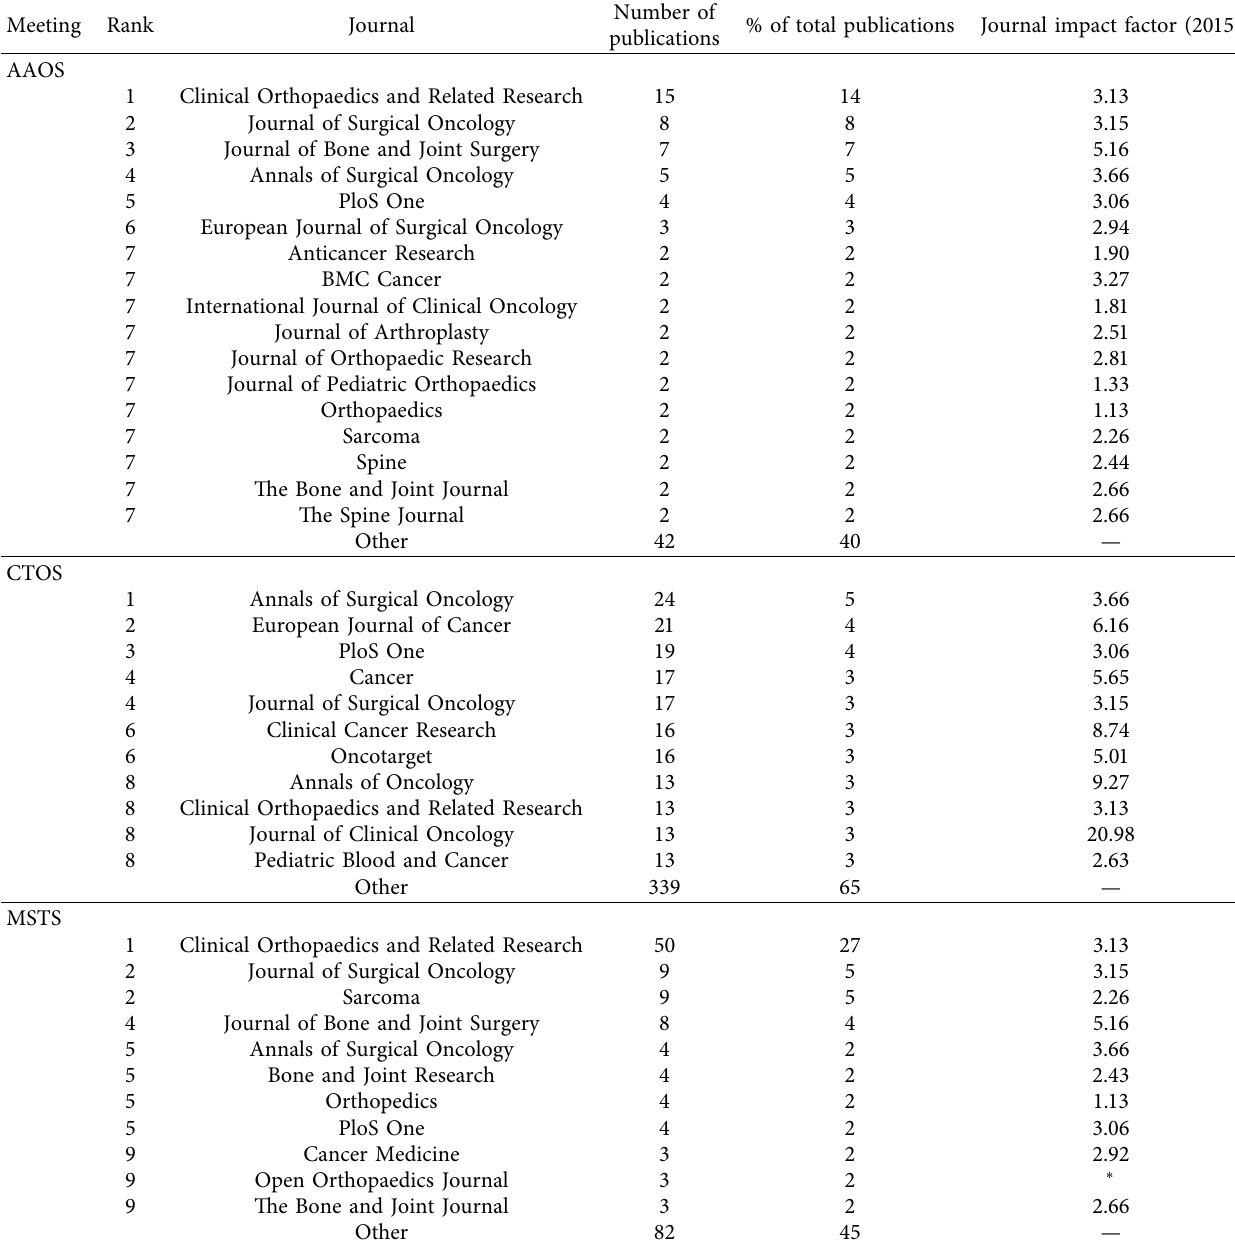
Table 2: Top ten journals with most publications from select AAOS, CTOS, and MSTS annual meetings.